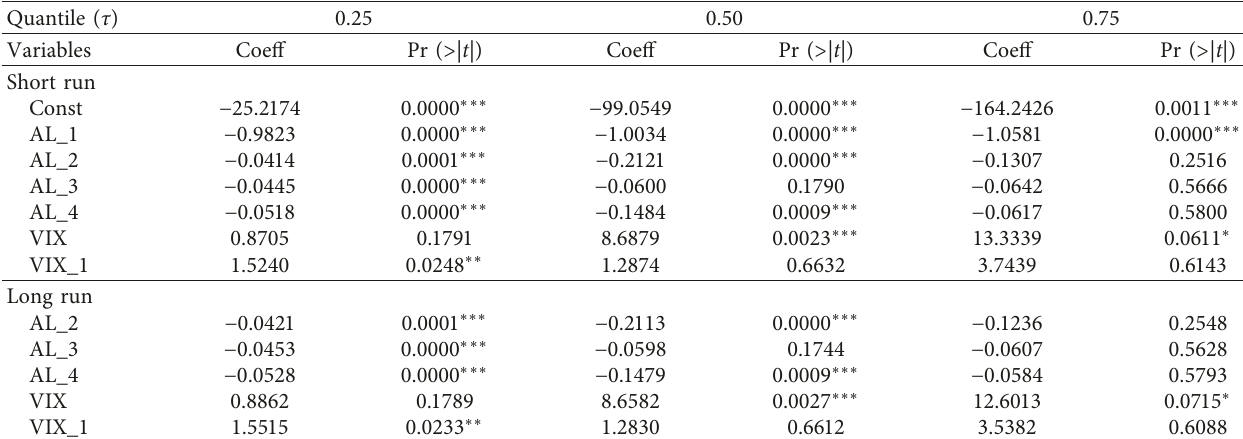
Table 5: QARDL estimation results: tranquil period (independent variable: VIX).